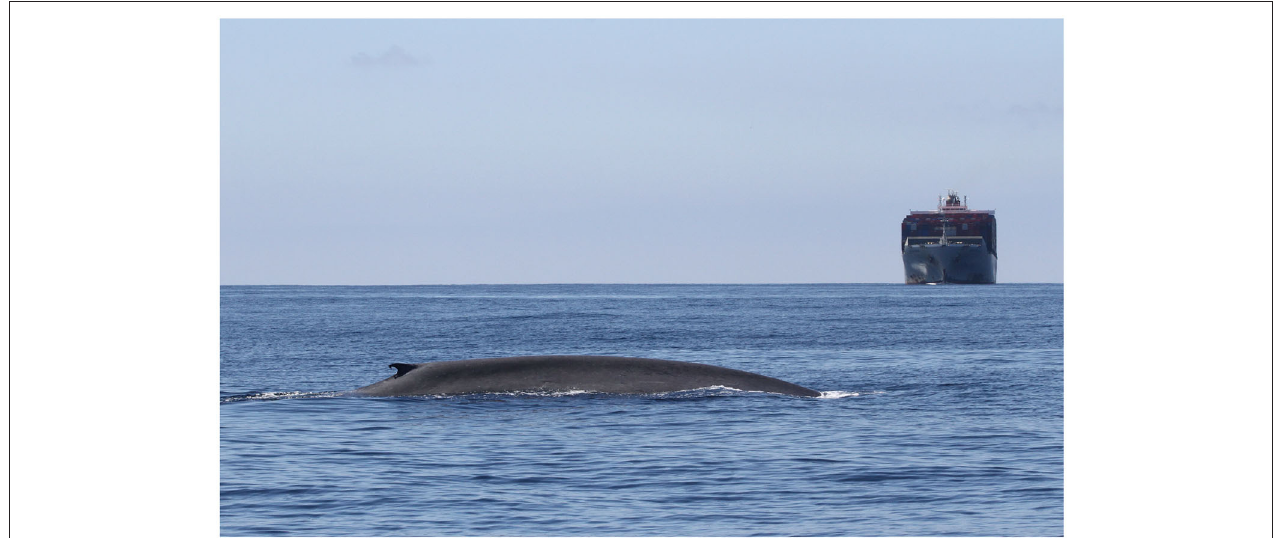
FIGURE 3 | Photo of a blue whale in front of a large vessel off California on 4 September 2014. Photo taken by John Calambokidis of Cascadia Research, as part of the diurnal ship strike risk assessment ( Calambokidis et al.).